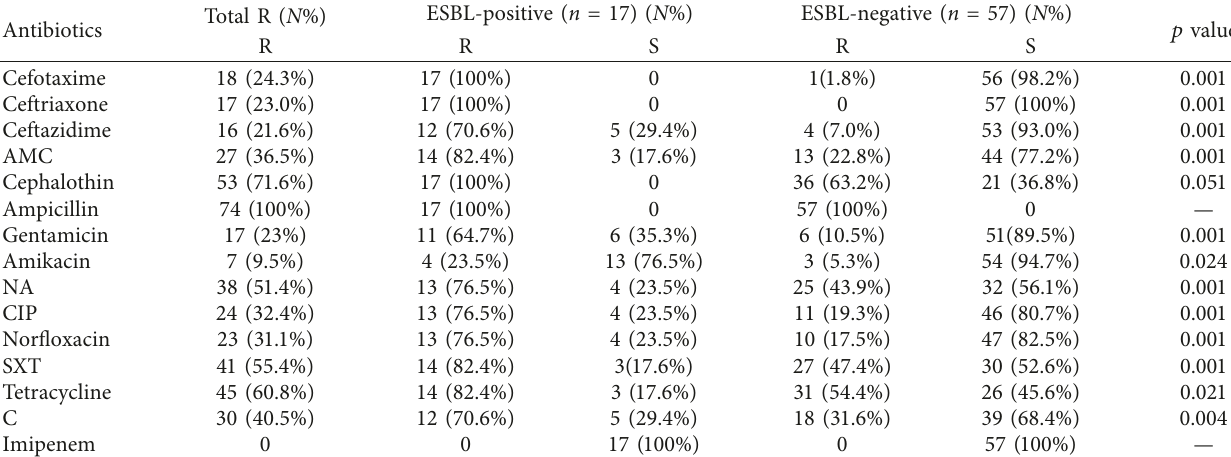
Table 3: Resistance profiles of ESBL-producing and non-ESBL-producing Escherichia coli and Klebsiella pneumoniae isolates in JUSH, Southwest of